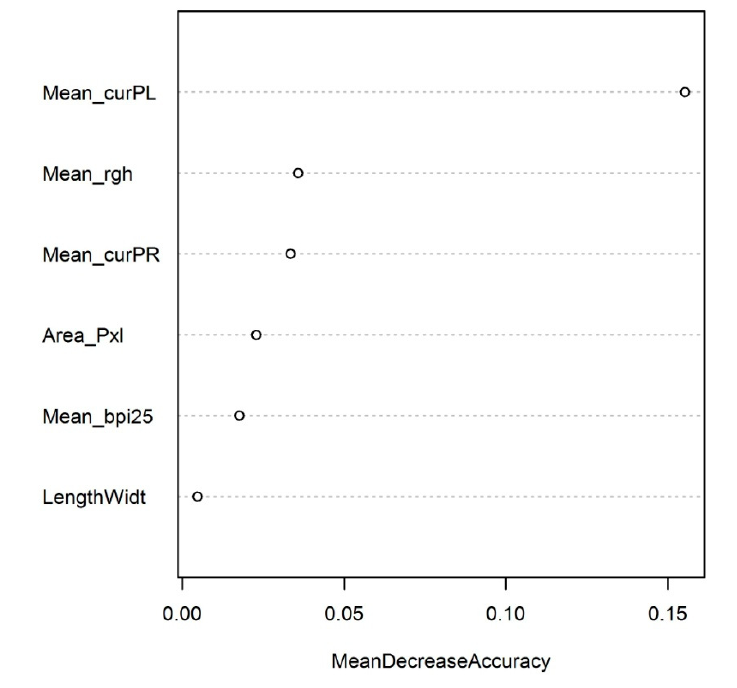
Figure 7. Predictor feature importance expressed as the mean decrease in accuracy when a feature is randomised. Larger decreases mean that the feature is more important. The mean decrease in accuracy ranges from 0 to